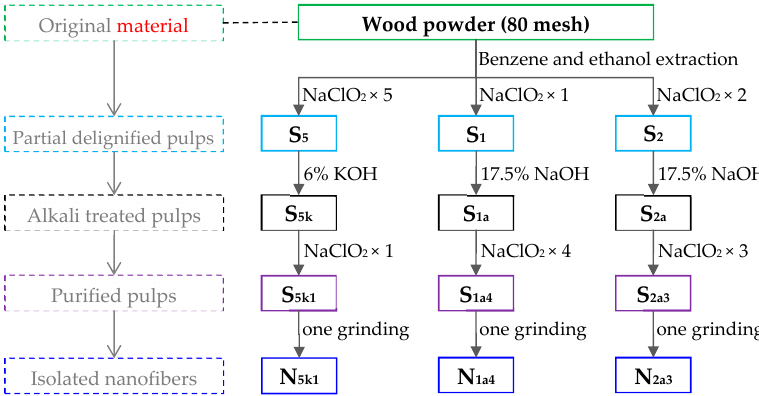
Figure 1. The procedure for the preparation of three types of cellulose nanofibers (CNFs) with different chemical treatments.